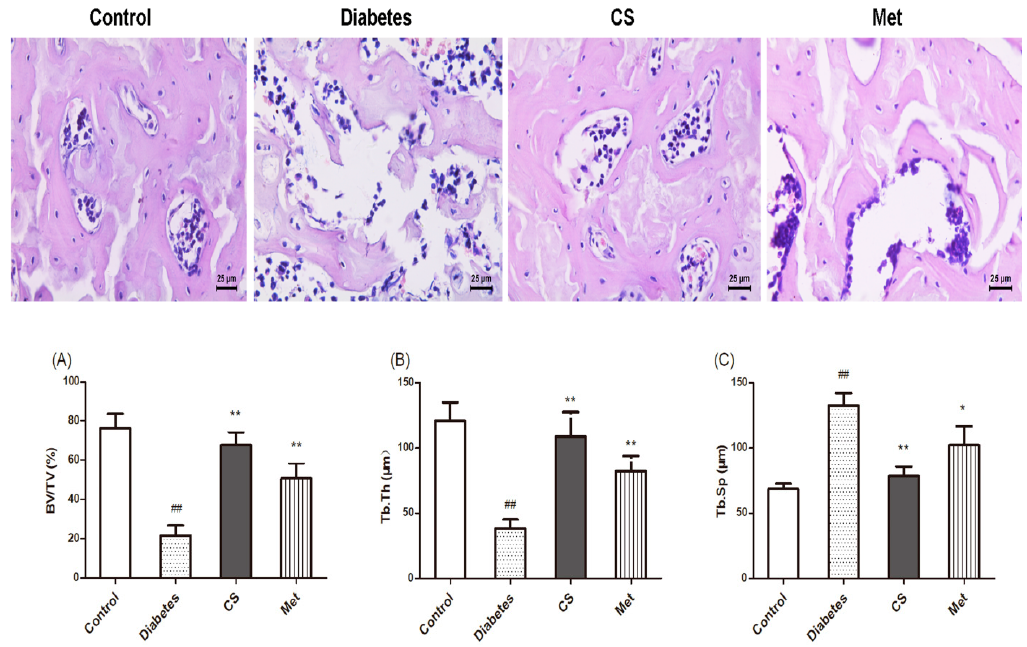
Figure 5. Morphology of femoral bone of rats in each group, hematoxylin and eosin staining, magnification, 400×. ( A ) Percentage of trabecular volume in each groups; ( B ) trabecular thickness in each groups; ( C ) trabecular spacing in each groups. ## p < 0.01 compared with the control group; ** p < 0.01 compared with the diabetic group, * p < 0.05 compared with the diabetic group.